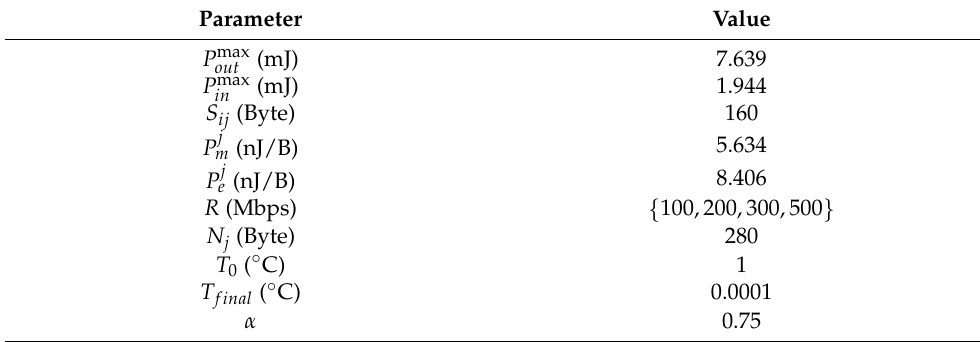
Figure 4. The snapshot of Iridium network at 1 January 2020 12 PM GMT (the satellite nodes are shown with blue circles, and the satellite gateways are denoted with orange). Table 3. Simulation